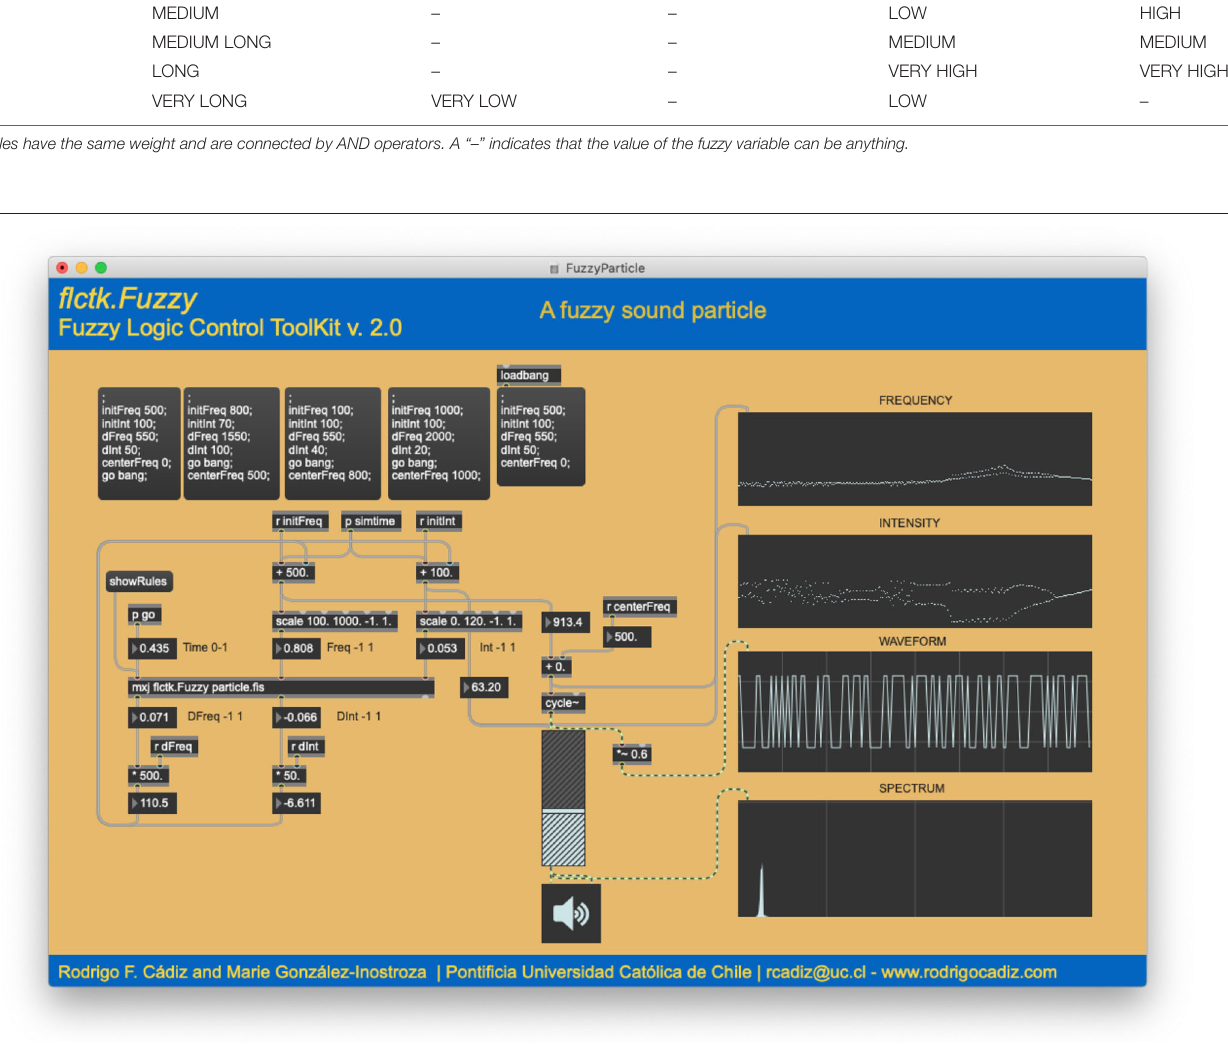
Frontiers in Artificial Intelligence |